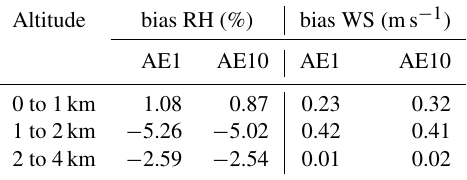
Table 3. Mean biases (mod–obs) of observed and modeled (exper- iments AE1 and AE10) vertical profiles of relative humidity (RH) and wind speed (WS) over three altitude ranges (i) from the surface to 1km, (ii) from 1–2km, (iii) from 2–4km, using the average of 157 radiosondes launched during the period 1–7 July 2016. Altitude